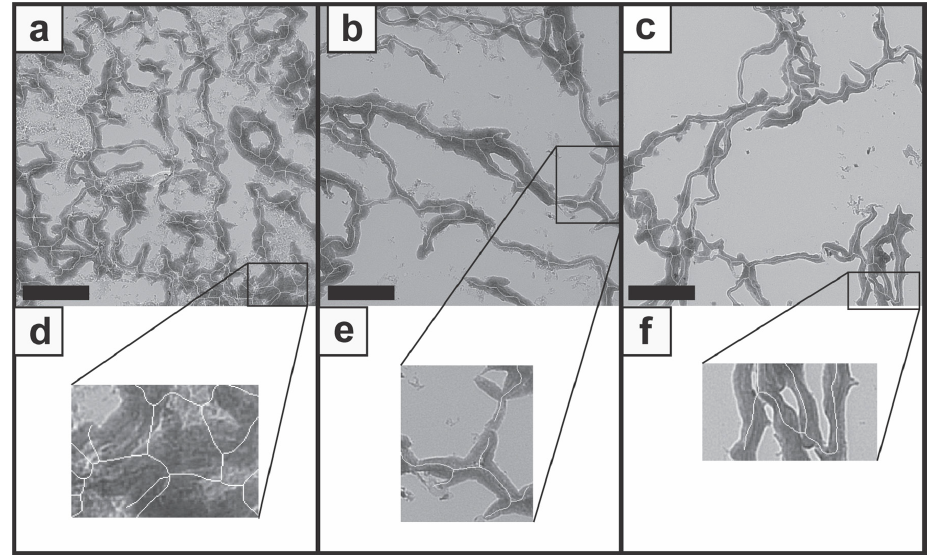
Figure 5. Images present false feature identification during the processing workflow. Incorrect determination occurred within images with larger stained zones ( a ), with unclear transitions ( b ), and for struts next to the image edge ( c ). Detailed views are presented for the three cases ( d , e , f ). Scale bars represent 100 µm.